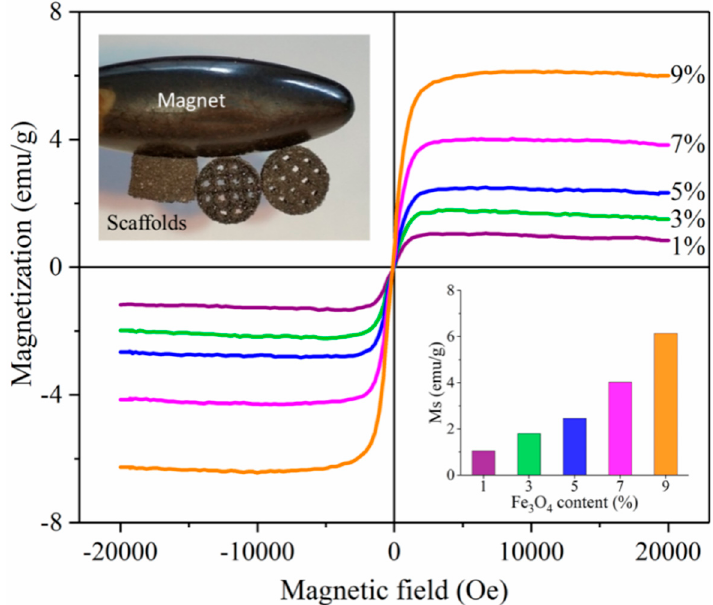
Figure 3. Magnetic properties of composite scaffolds. The main picture was the magnetization curves of the composite scaffolds in the magnetic field at room temperature. The illustration in the upper left corner was an optical view of the PLLA / 7%Fe 3 O 4 composite scaffold attracted by the permanent magnet from different sides. The illustration in the lower right corner was the saturation magnetization (Ms).